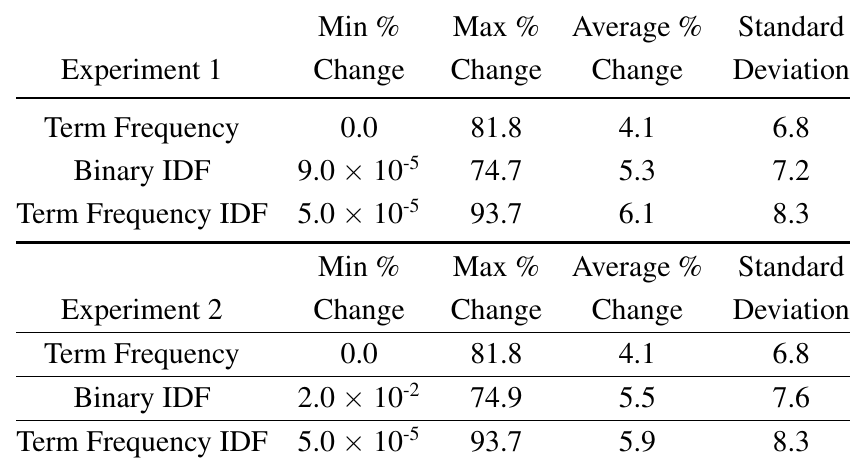
Table 5. Change in document-to-document similarity matrices when tabular information is excluded from patent documents; Experiment 1 removes numerical words and Experiment 2 includes numerical